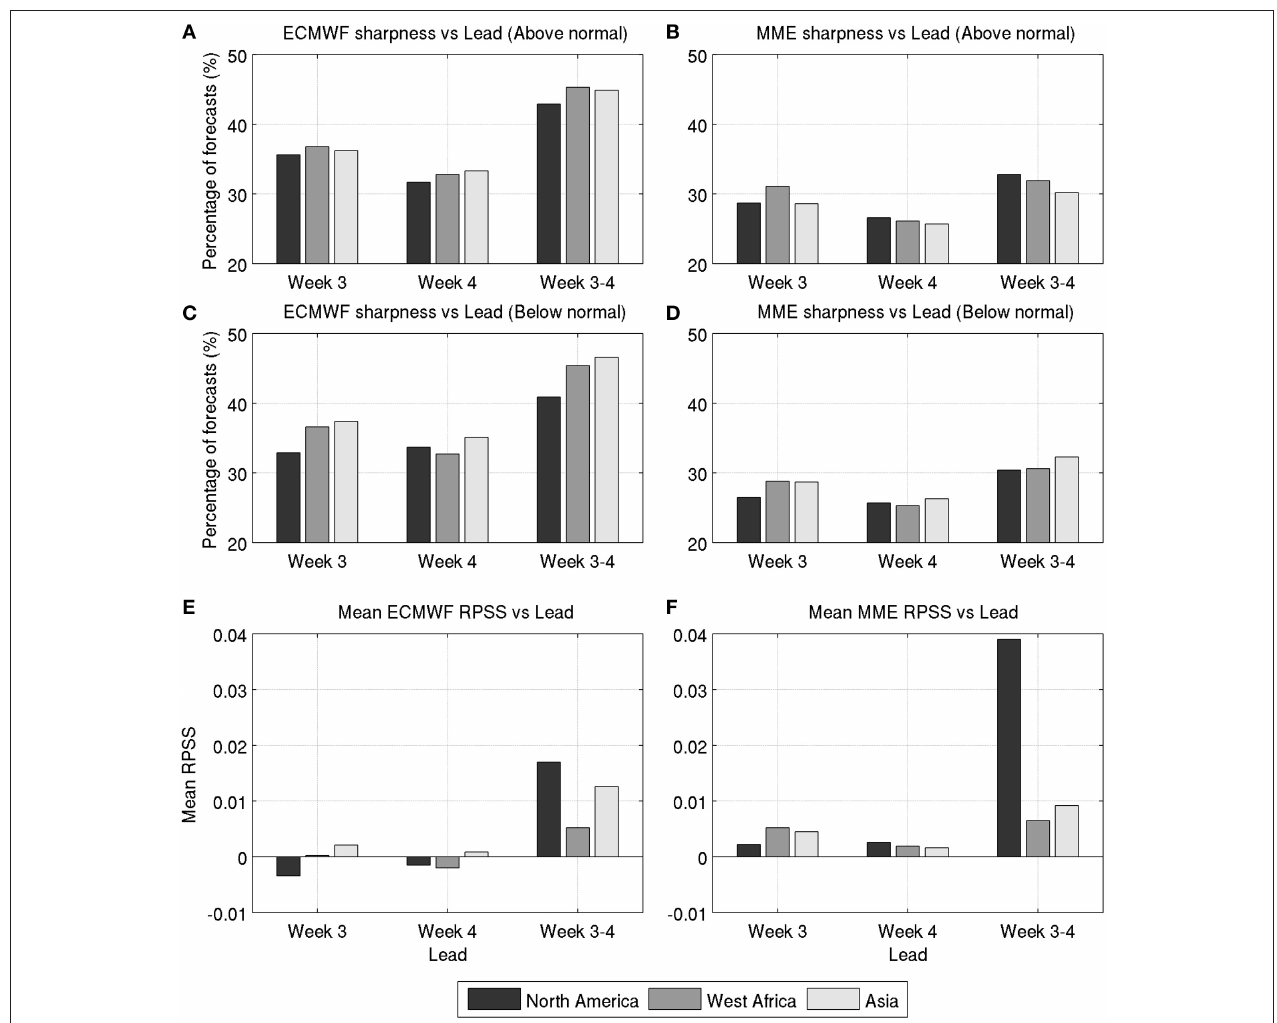
FIGURE 9 | Percentages of forecasts in all bins except for the 4th bin (0.33) shown in Figures 2 – 4 for week 3, week 4, and week 3–4 forecasts from ECMWF (A,C) and the MME of ECMWF, NCEP, and CMA forecasts (B,D) for the Above and Below normal categories, together with related RPSS spatially averaged over each monsoon region (E,F) .